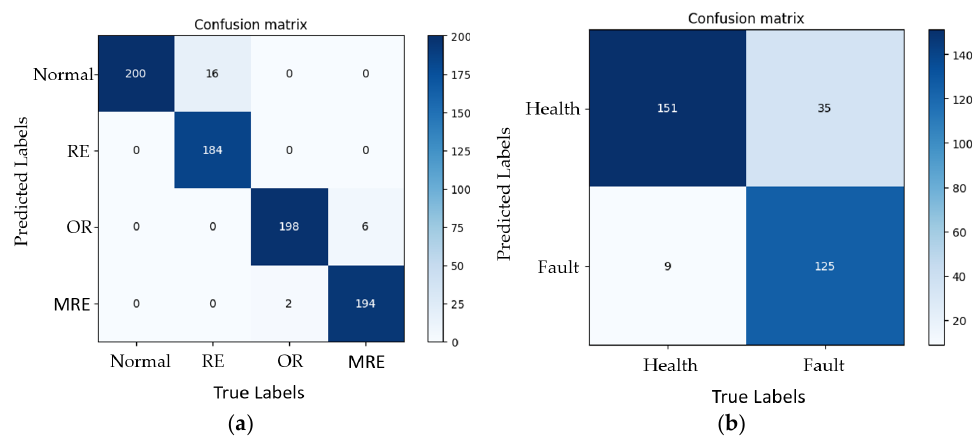
Figure 13. Test confusion matrix: ( a ) bearing fault simulator; ( b ) wind turbine spindle bearing. Table 8. Precision and recall of diagnosis models.